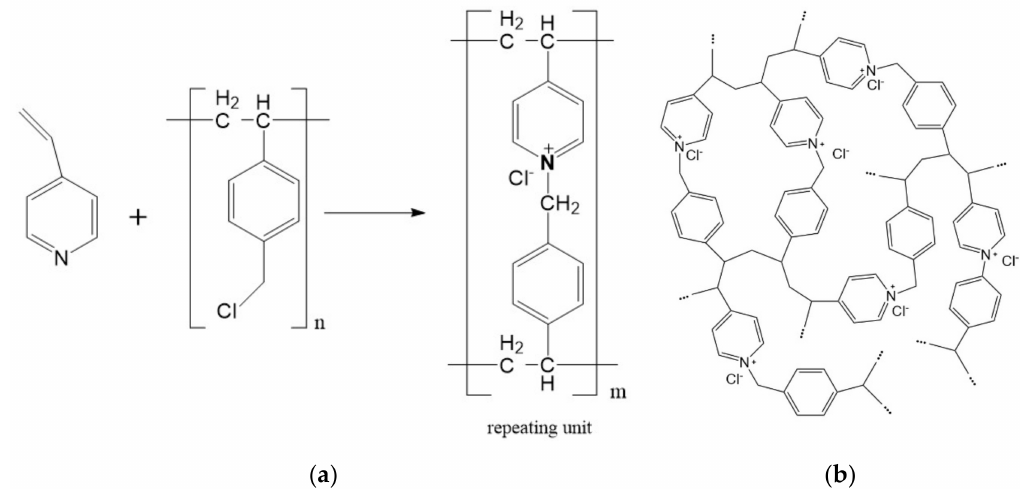
Figure 1. Scheme of synthesis and structure PVBC-VP: ( a ) scheme of synthesis and structure of repeating unit of PVBC-VP; ( b ) visualization of crosslinked net structure of PVBC-VP (where “ · · · ” symbolizes the continuation of the polymer chain).